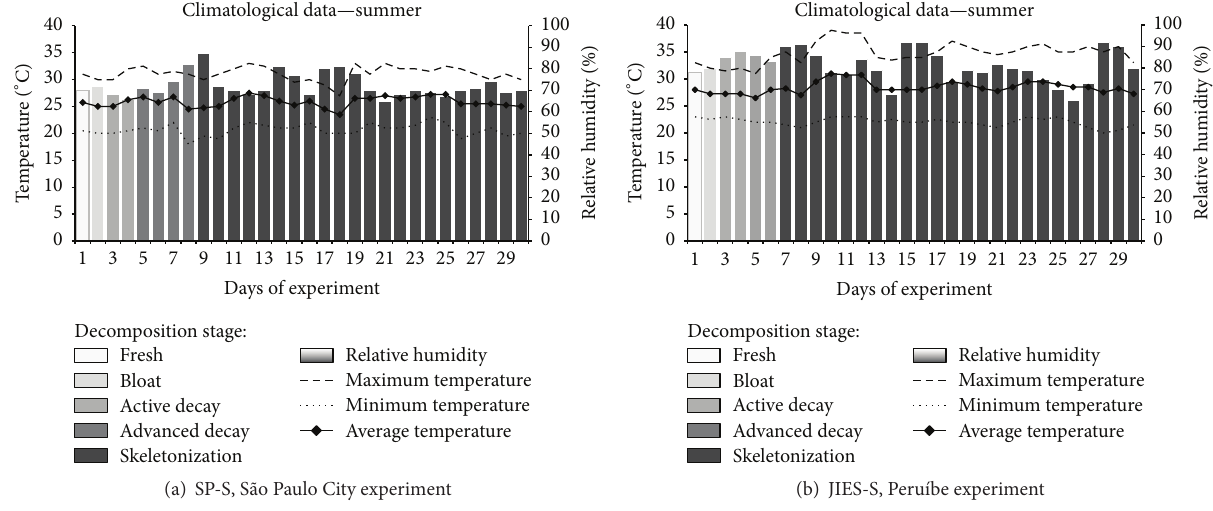
Figure 1: Climatological data for the summer experiments.